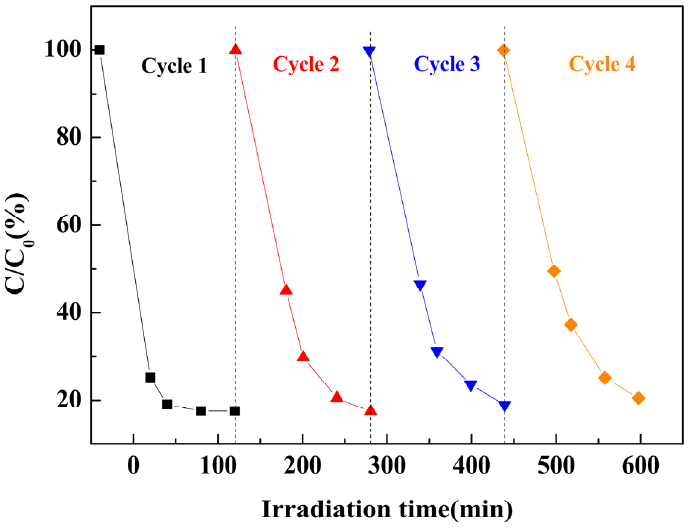
Figure 11. Cycle experiment of 80ZIS/CN photocatalytic degradation of TC.